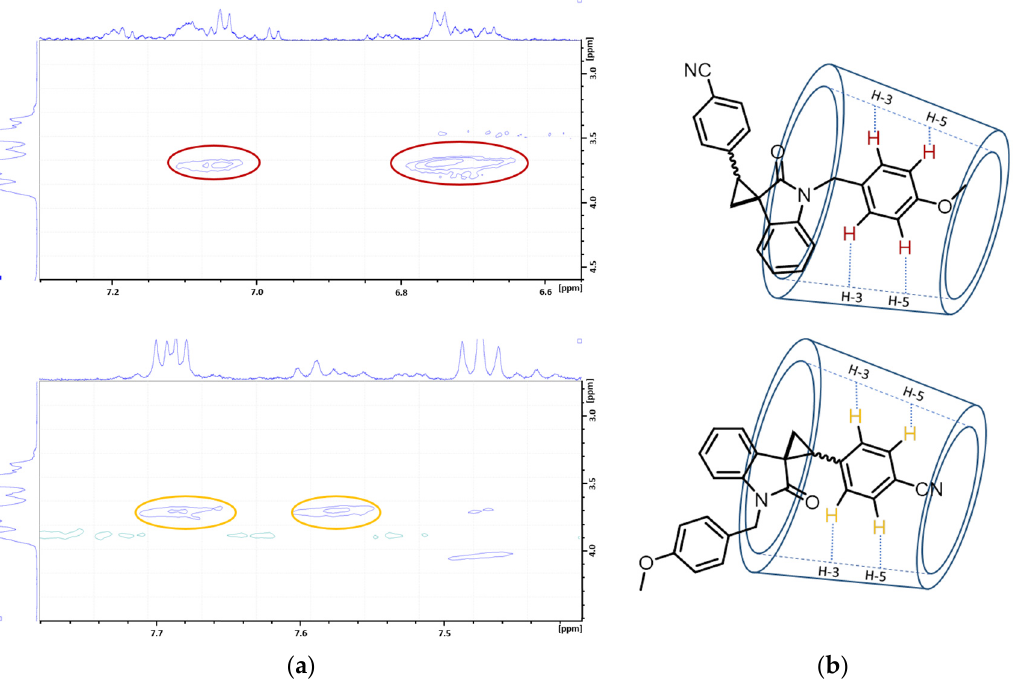
Figure 10. ( a ) Fragment of 1 H- 1 H ROESY NMR spectrum of the HP β CD- 2b complex; ( b ) possible inclusion modes of HP β CD- 2b .